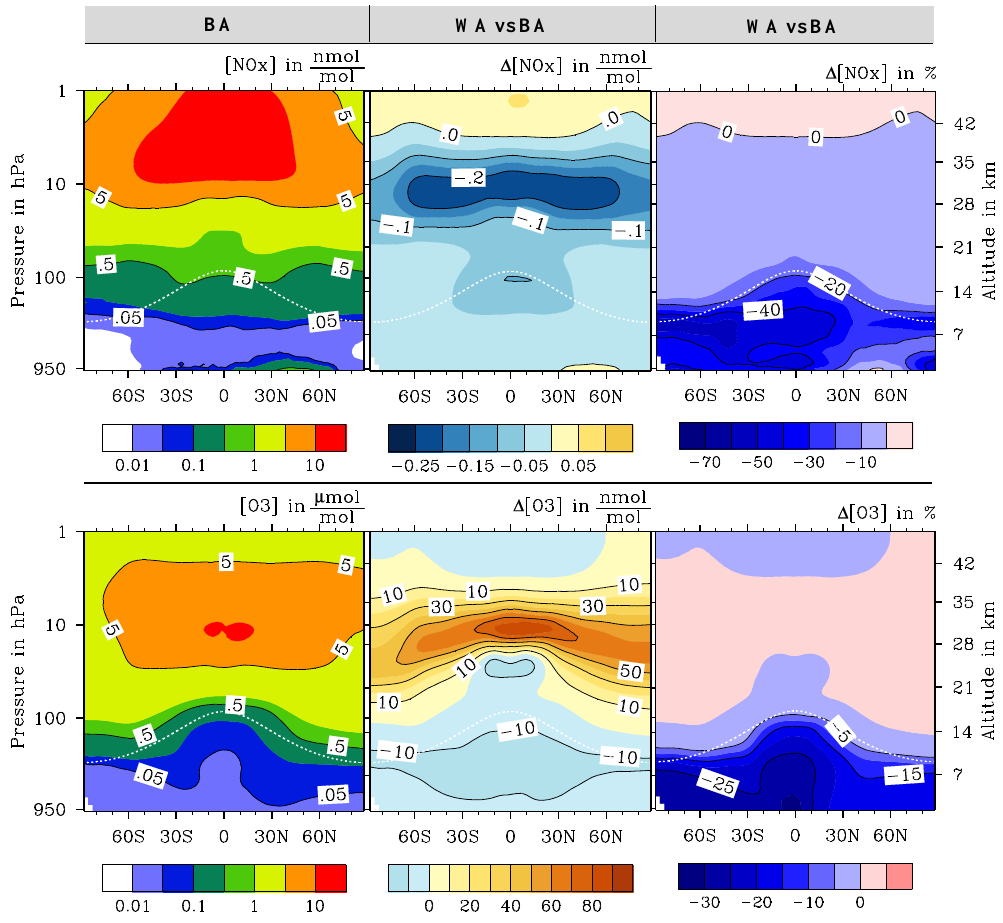
Fig. 1b. As Fig. 1a, but for [NO x ] and [O 3 ]. See Fig. S6 of the Supplement for respective plots for [HO 2 ] and [NO y